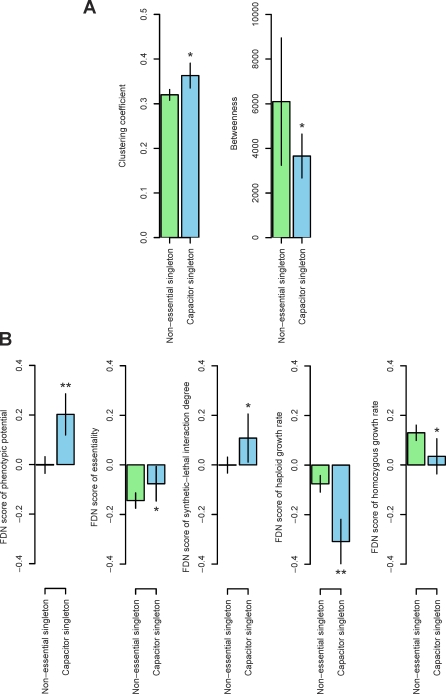
Network characteristics of capacitor singletons(A) The clustering coefficient (left) and betweenness centrality (right) of all nonessential singletons (light green) and capacitor singletons (light blue).(B) Properties of the immediate PPI neighbors of a gene controlled for the degree of that gene (FDN score, see methods) for all nonessential singletons (light green) and capacitor singletons (light blue). From left to right: the phenotypic potential, the number of essential genes, the fraction of SLIs in the literature-curated BioGRID network, the haploid growth rate when deleted, the diploid growth rate when both copies are deleted. Error bars represent the standard error of the mean. Wilcoxon-Mann-Whitney test: *, p < 0.05; **, p < 0.01.